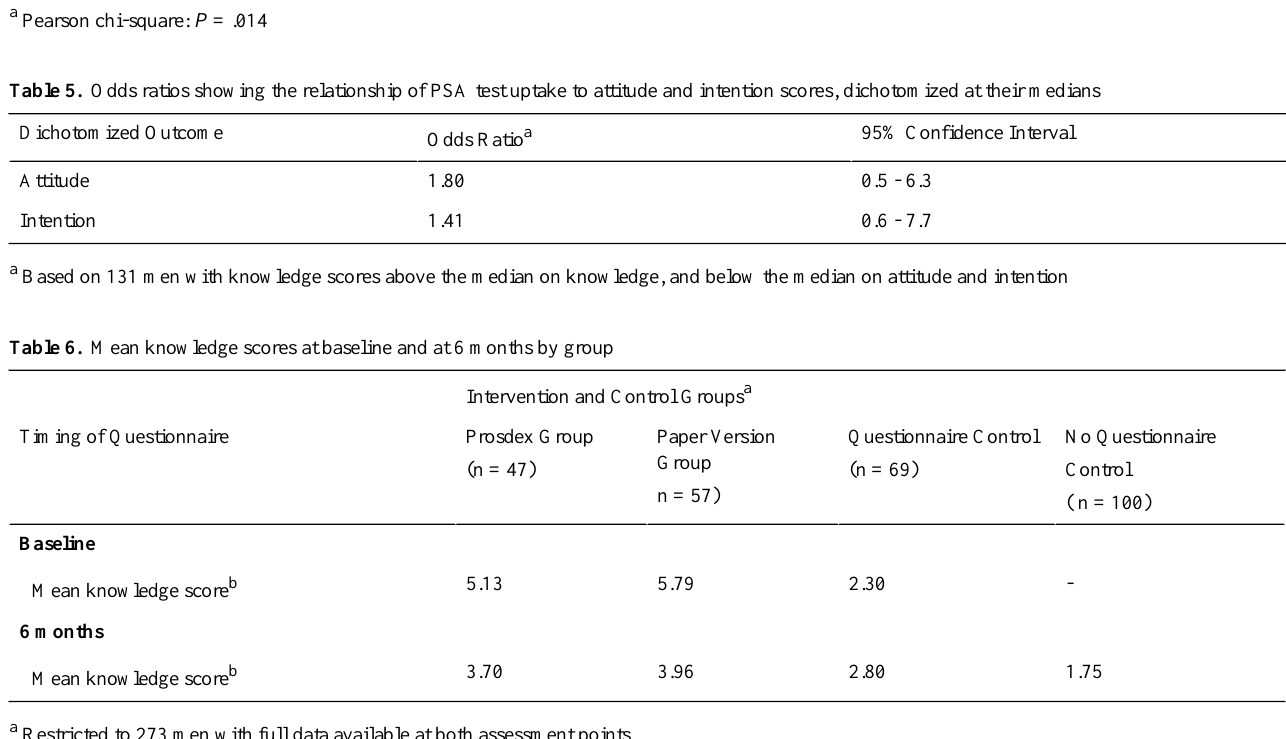
All GroupsNo Questionnaire